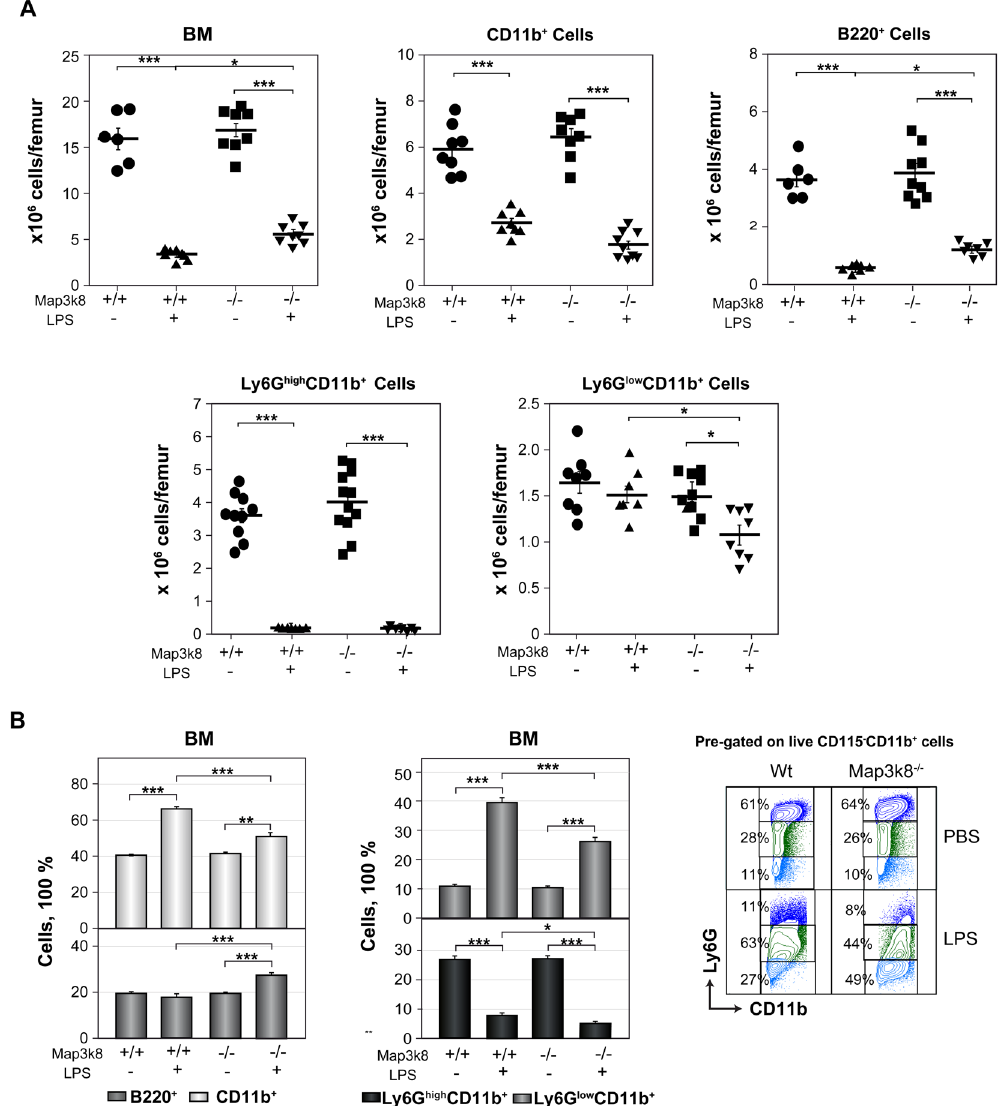
Figure 2. Analysis of BM cells in LPS-treated Wt and Map3k8 − / − mice. Wt and Map3k8 − / − mice received two injections of LPS or PBS; 24 h after the last injection, BM cells were isolated and subjected to flow cytometry analysis. ( A ) Total cellularity of BM and numbers of BM CD11b + myeloid and B220 + B cells and of Ly6G high CD11b + mature and Ly6G low CD11b + immature neutrophils. ( B ) Frequency of the cells described in ( A ) relative to the total number of BM cells. On the right, representative dot plots show the percentage of Ly6G high CD11b + mature and Ly6G low CD11b + immature neutrophils relative to the total number of BM CD115 − CD11b + myeloid cells. The data are presented as the mean ± SEM from at least 3 independent experiments performed in duplicate. Newman-Keuls tests were performed to analyse significant differences among groups. * p < 0.05, ** p < 0.01, *** p <